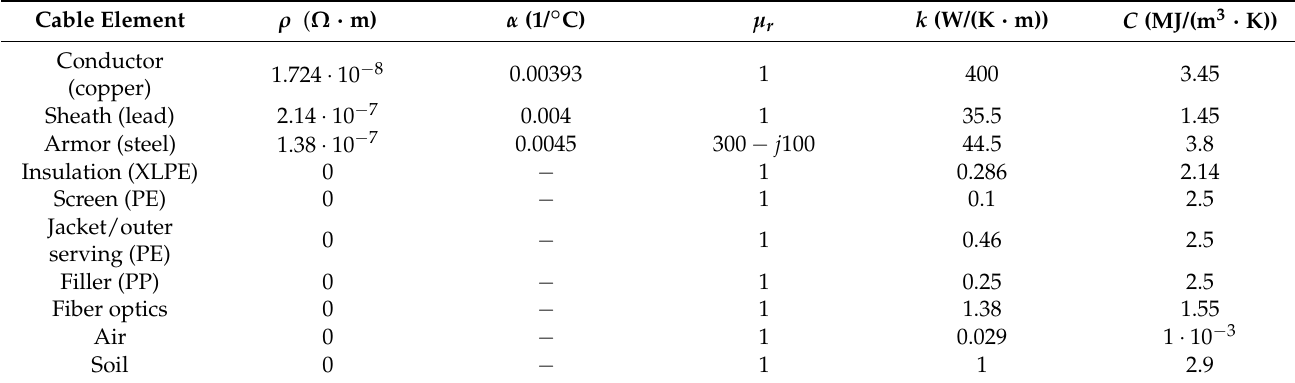
Table 2. Main material parameters of Cables 1 and 2.